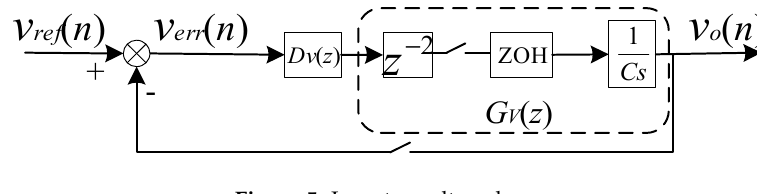
Figure 5. Inverter voltage loop.